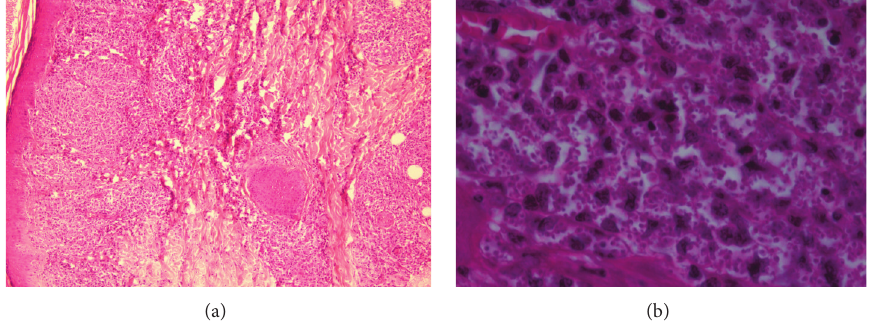
Figure 2: Skin biopsy (a). A dense mainly histiocytic infiltrate in the papillary and reticular dermis (H&E x100) (b). Many histiocytes loaded by Leishman bodies (H&E x400).